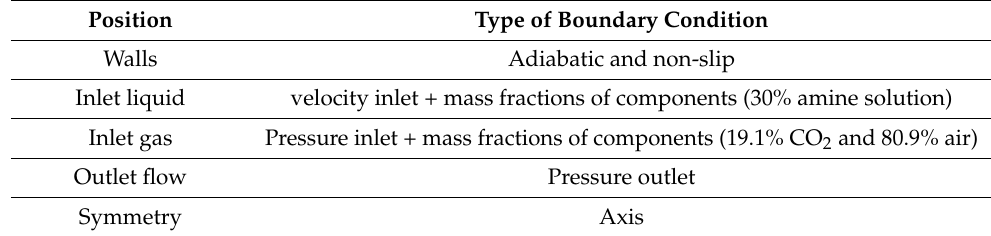
Table 4. The boundary conditions of the simulated 2D